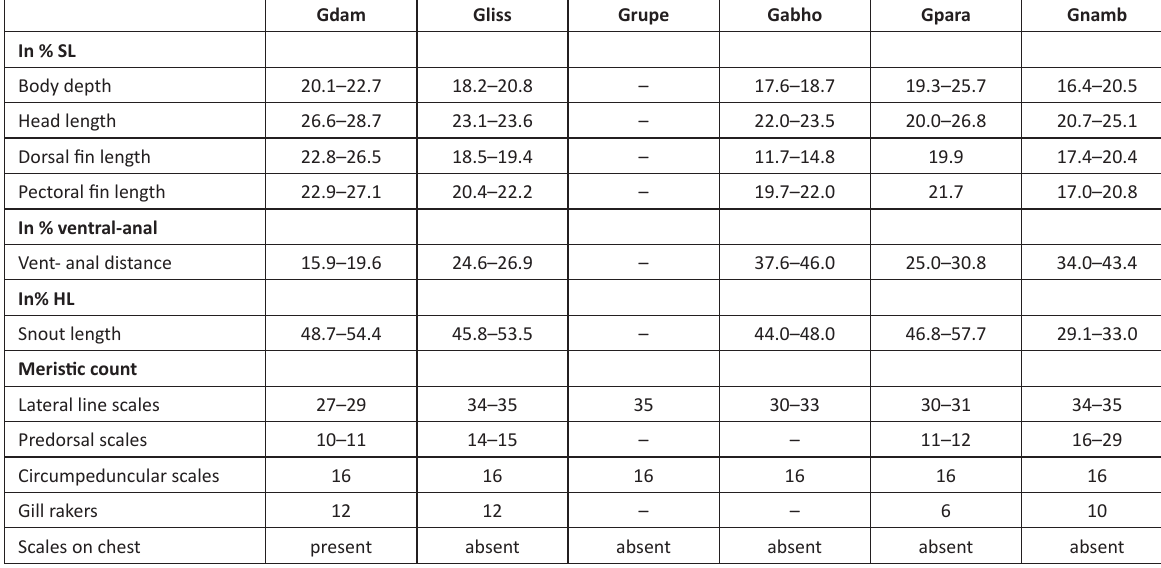
Table 2. Comparison of Garra dampaensis sp. nov. with related